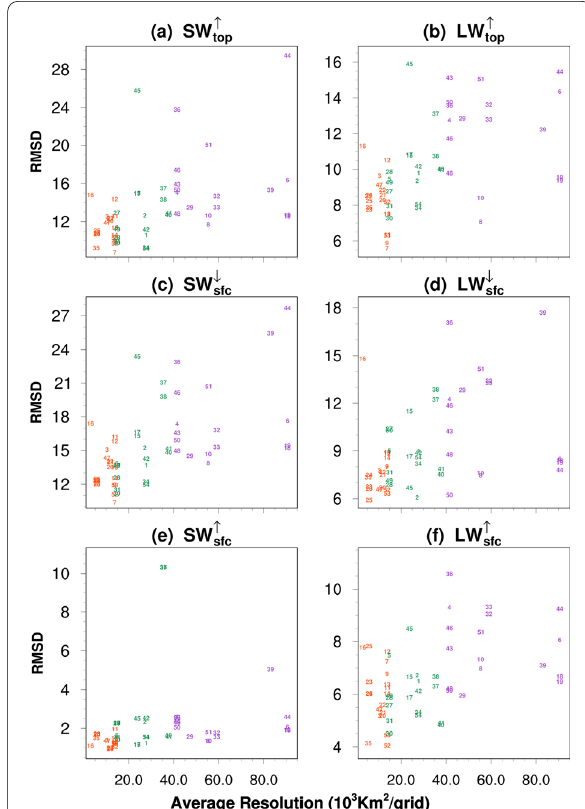
in wattm − 2 ) of six model radiative fluxes against the CERES‑EBAF data and their dependence on model horizontal resolution. The six radiation variables include upward shortwave and longwave fluxes at TOA (i.e., SW ↑ top and LW ↑ top ), downward shortwave and longwave fluxes at surface (i.e., SW ↓ sfc and LW ↓ sfc ), and upward shortwave and longwave fluxes at surface (i.e., SW ↑ sfc and LW ↑ sfc ). Models classified as high‑, medium‑ and low‑horizontal resolution groups are highlighted in orange, green and purple, respectively. All radiative fluxes are under all‑sky condition and are averaged over the global tropical ocean from 30° S to 30°